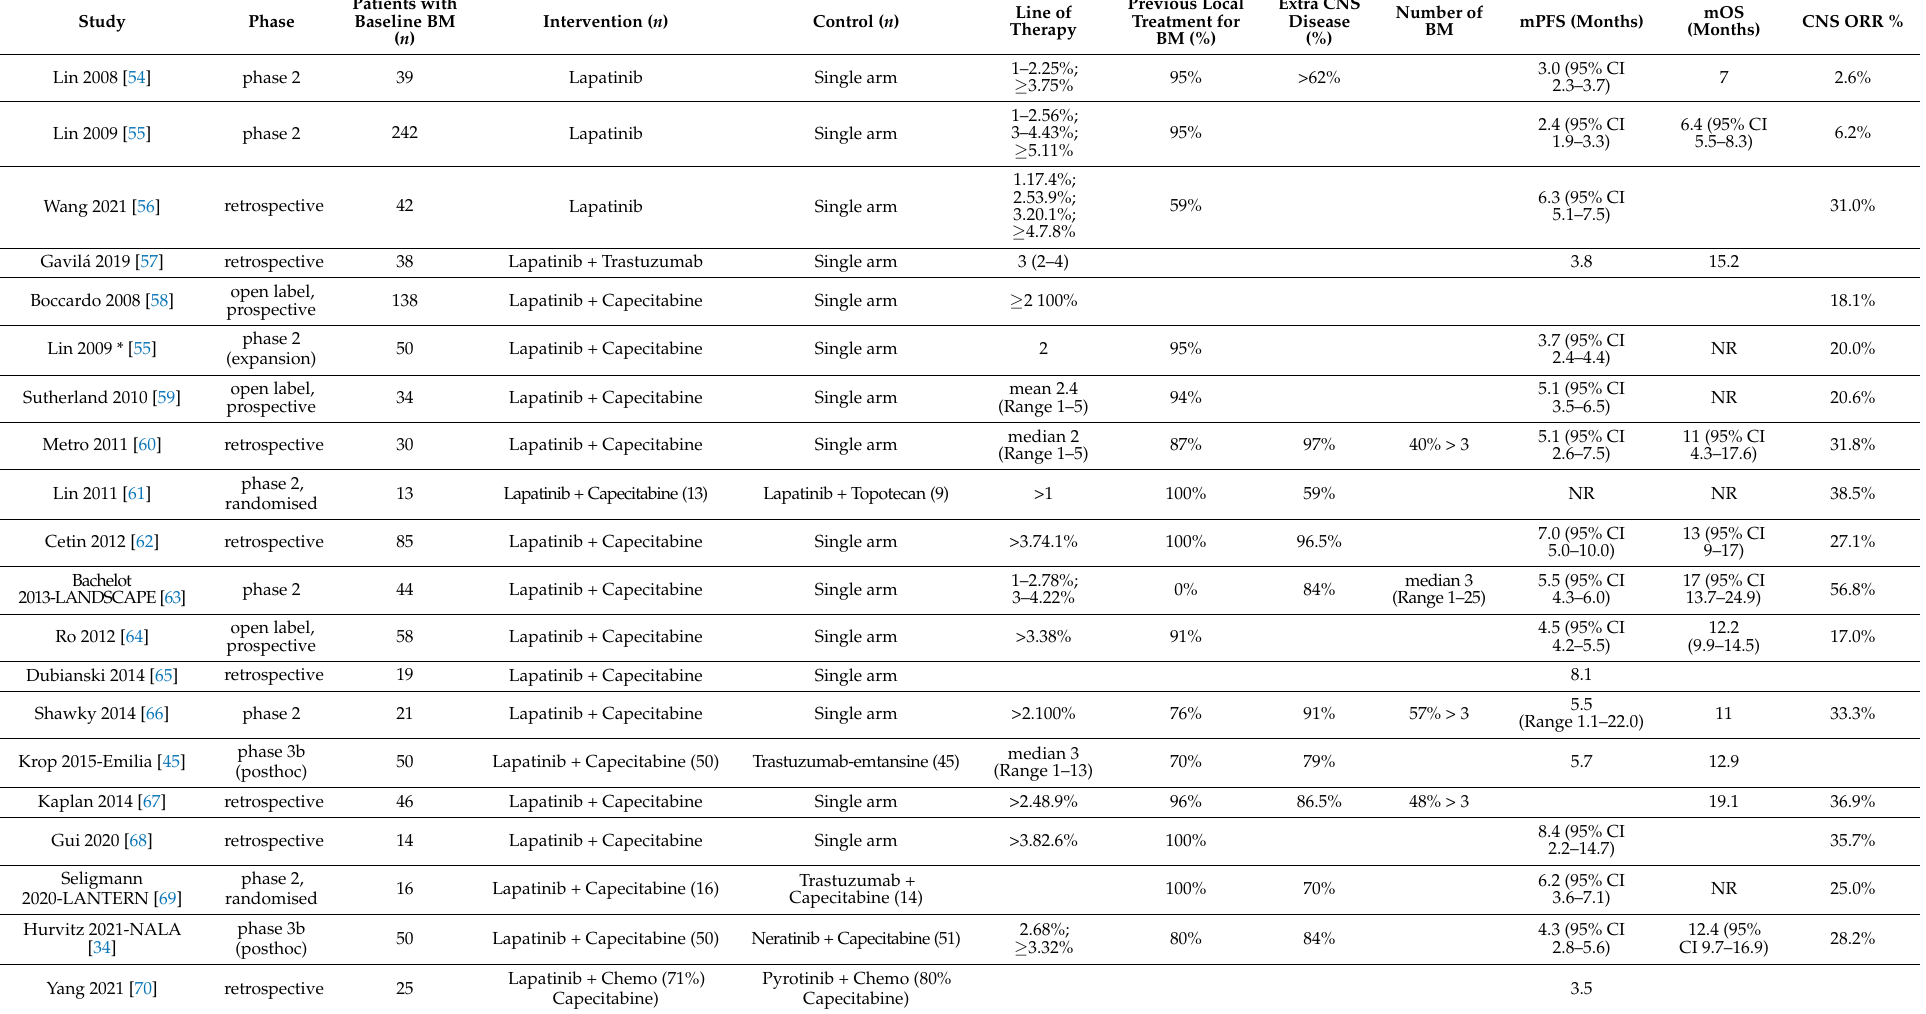
Table 3. Characteristics of included Lapatinib and/or Capecitabine studies (n =